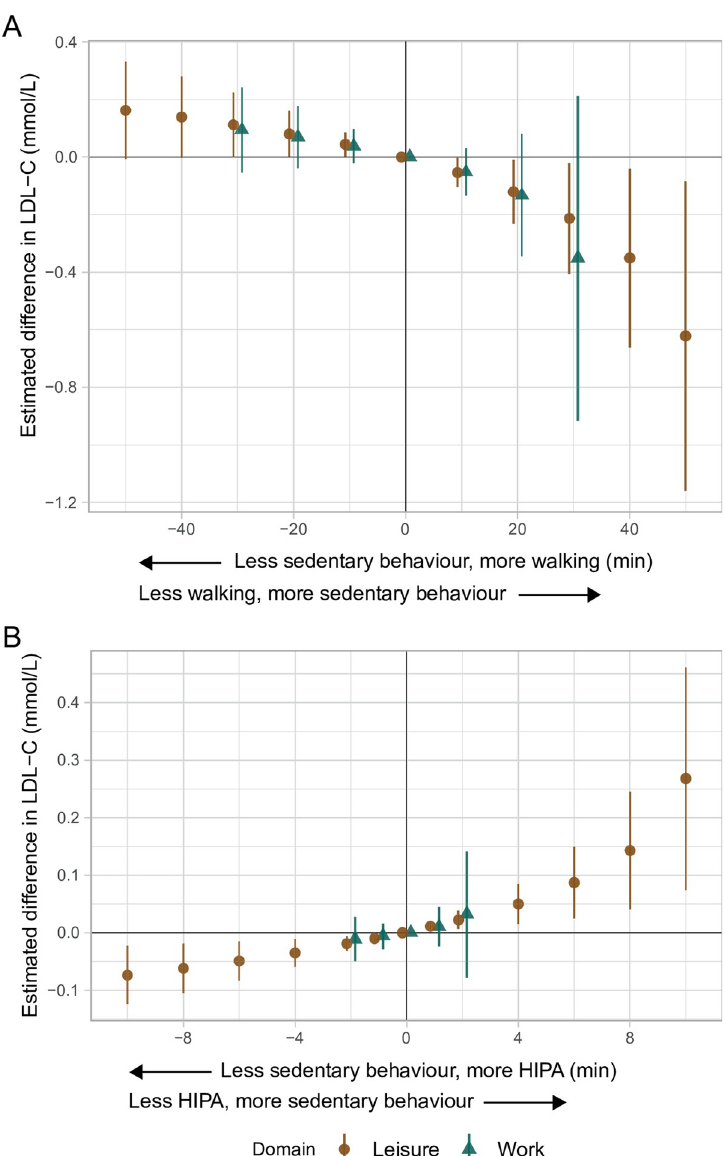
Fig 4. Adjusted estimated differences in low-density lipoprotein cholesterol (mmol/L, y-axis) given the reallocation of time between sedentary behaviour and A) walking, and B) HIPA among 652 adults. A negative value on the x-axis reflects the pairwise reallocation of time from sedentary behaviour to walking or HIPA, while a positive value reflects the reallocation of time from walking or HIPA to sedentary behaviour. The origin represents the reference composition (i.e., 372.7 and 234.2 min sedentary behaviour, 127.0 and 74.6 min standing, 49.1 and 22.5 min moving, 56.8 and 32.5 min walking, and 10.9 and 2.5 min HIPA, during leisure and work, respectively, and 457.3 min in bed). The difference in outcome was calculated by subtracting the estimated outcome of the reference composition from the estimated outcome for each reallocated composition. LDL-C is low-density lipoprotein cholesterol. HIPA is high-intensity physical activity (i.e., sum of climbing stairs, running, cycling, and rowing). Vertical lines correspond to the 95% confidence intervals. during both domains and in the sedentary behaviour and HIPA-reallocations during work (Table E and F in S3 File).